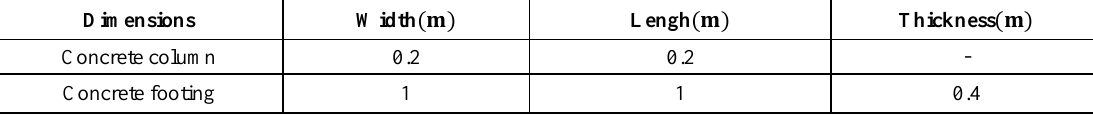
Table 2. Dimensions of the shallow